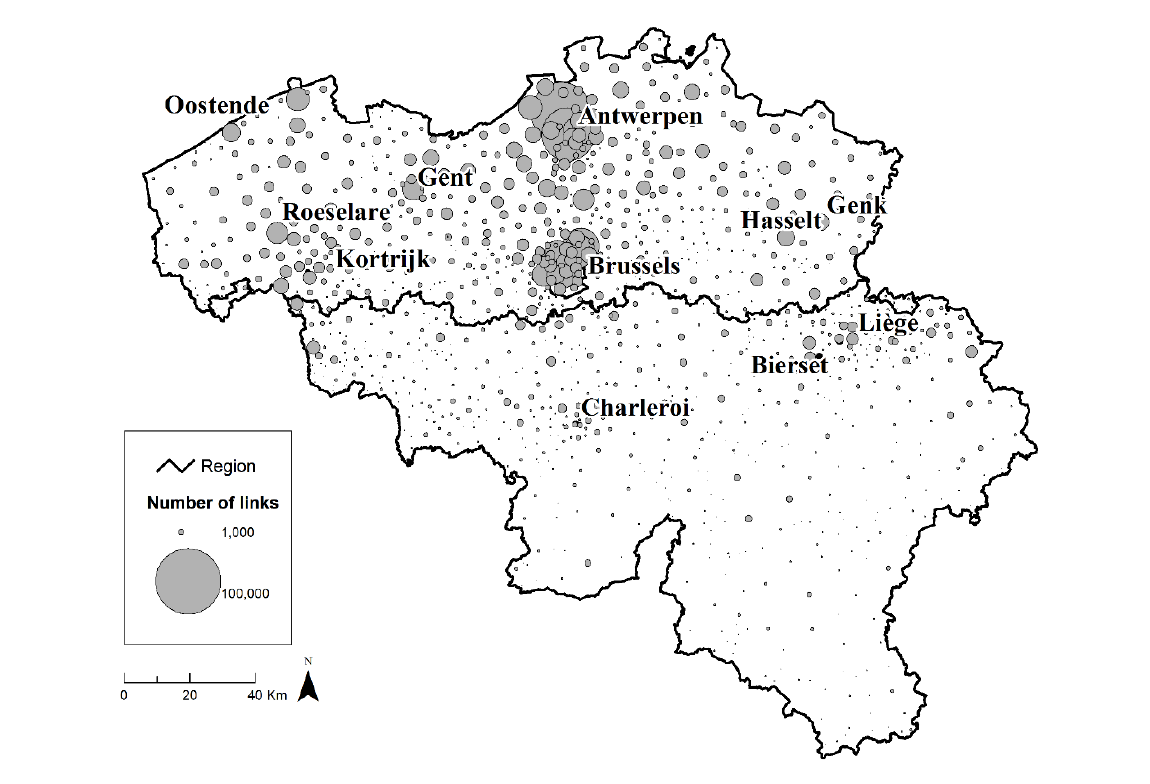
Figure 3: Total buyer-supplier linkages per zip